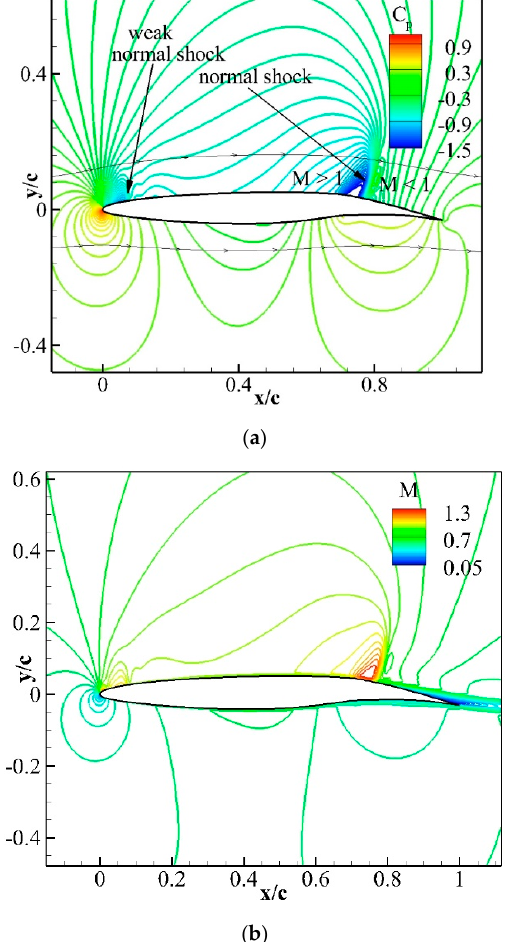
Figure 20. Computed ( a ) coefficient of pressure and ( b ) Mach contours for flow over the VCCTEF 6 airfoil at a zero angle of attack.